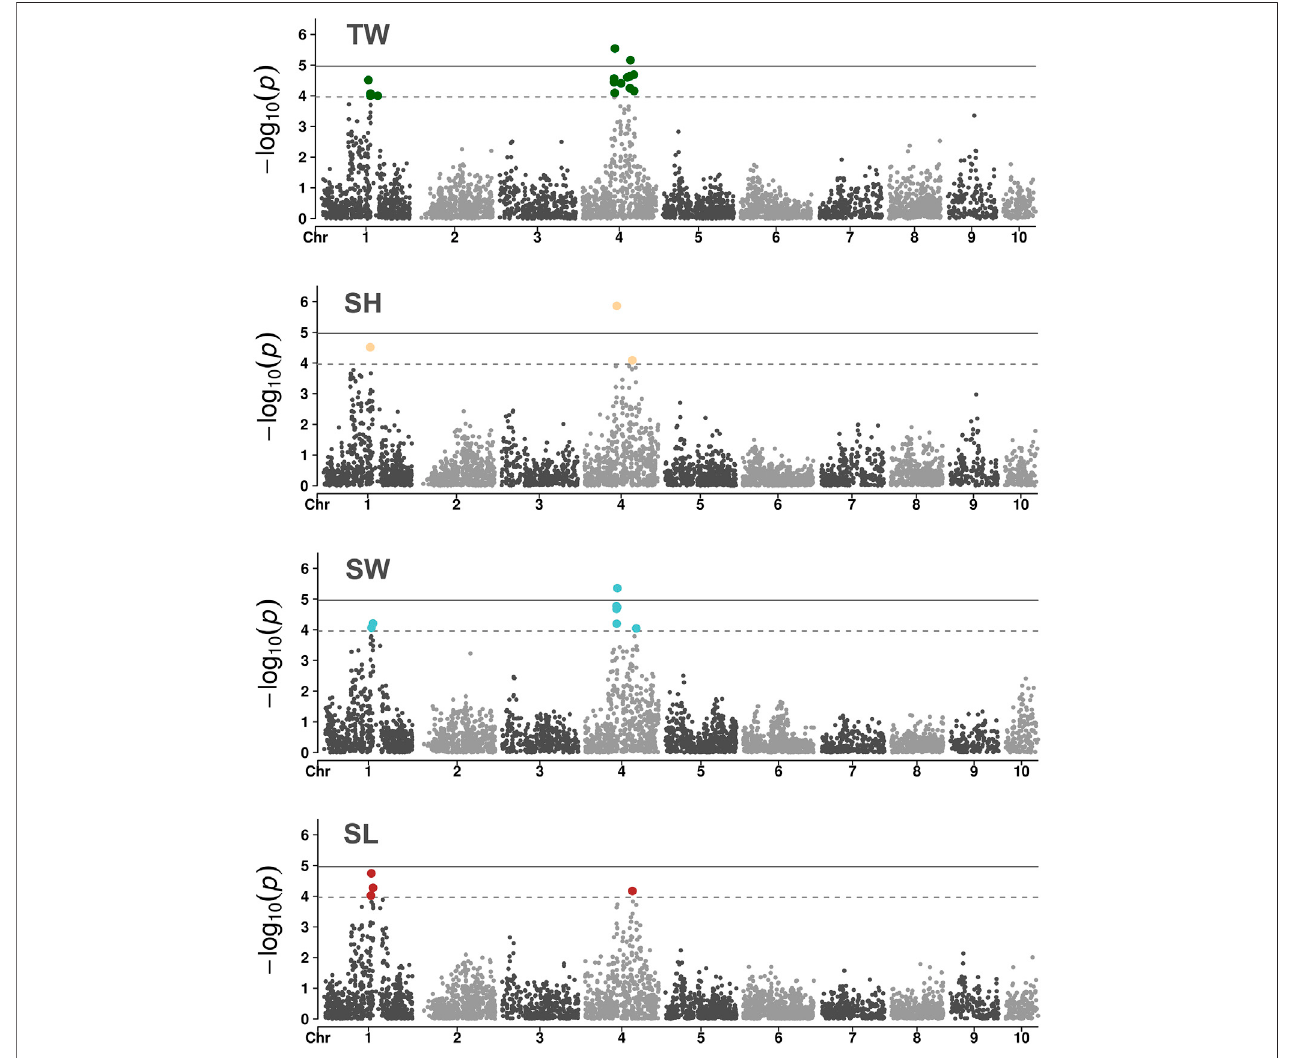
FIGURE 3 | Manhattan plots of the GWAS for growth-related traits in a European fl at oyster population. Solid lines indicate the threshold value for genome-wide signi fi cance. Dashed lines indicate the threshold for a suggestive (chromosome-level) signi fi cance.